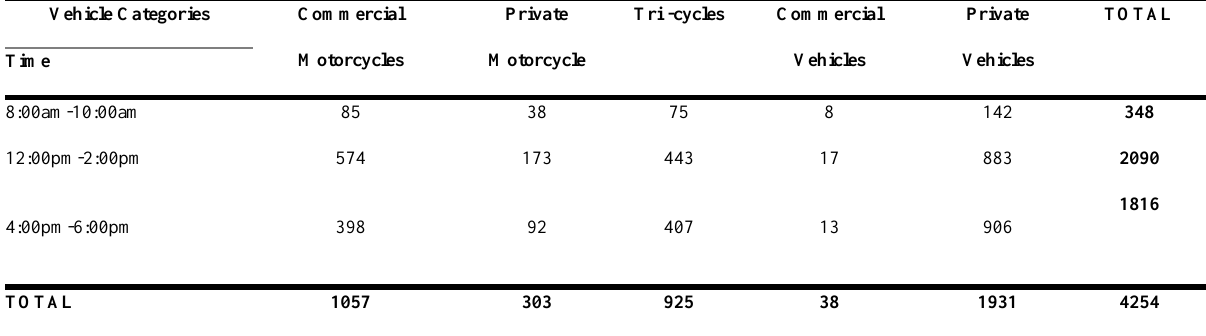
Table 6. Red Light Running Along Mobil Axis, Minna. Source: Medayese et al., 2016 Vehicle